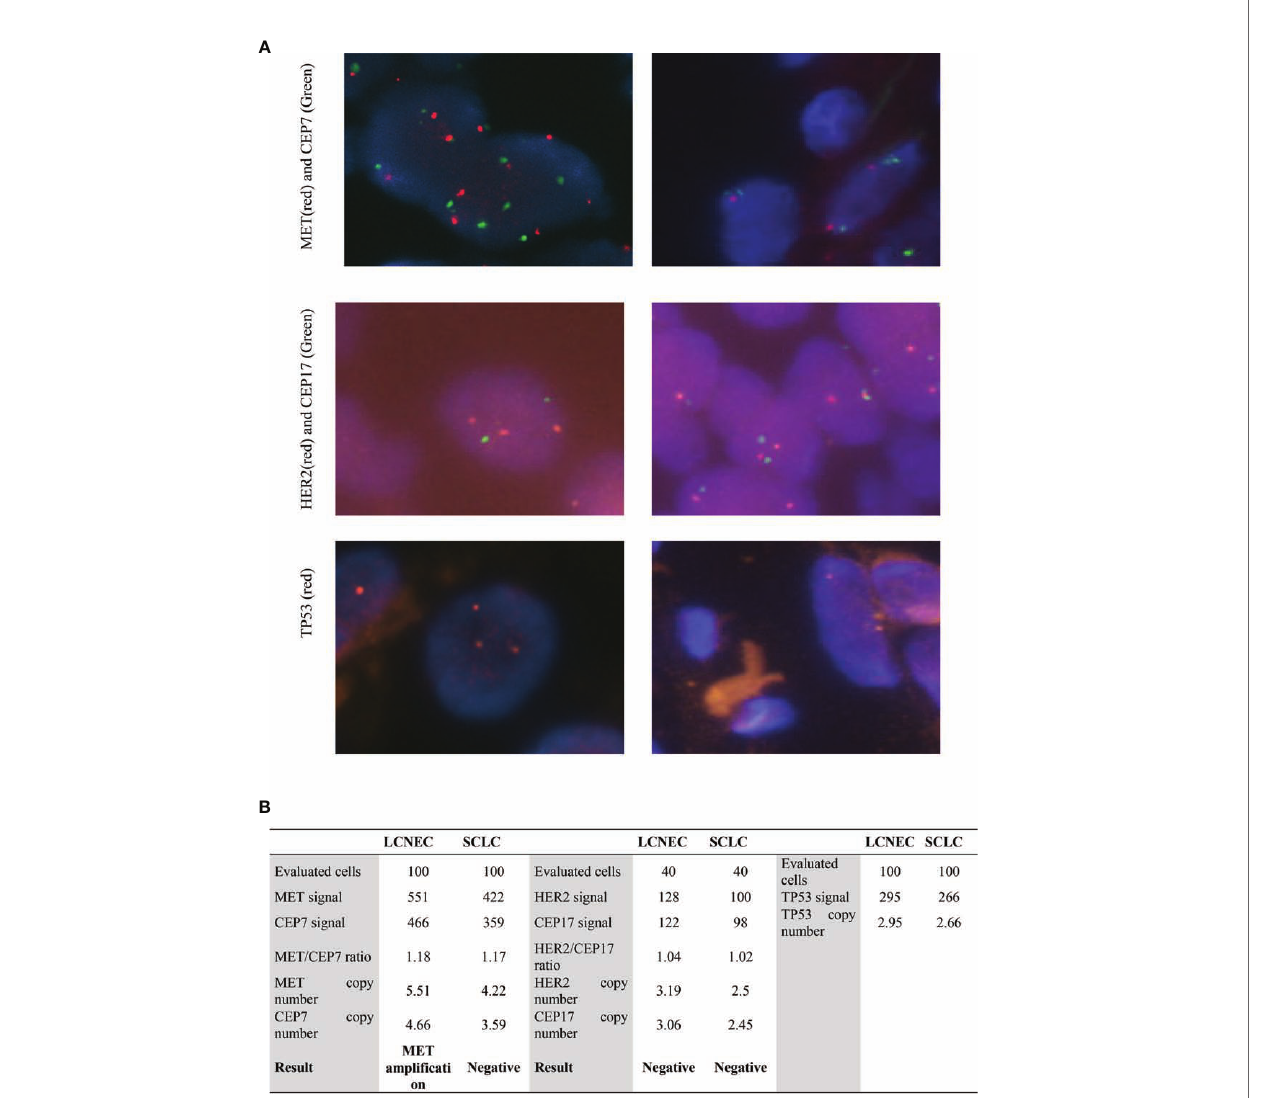
FIGURE 3 | Results of MET, HER2, and TP53 FISH in large- and small-cell components. (A) FISH images of MET, HER2, and TP53 FISH in LCNEC (left) and SCLC components (right). The magni fi cation was 1,000×. (B) Quanti fi cation of MET, HER2, and TP53 copy number in FISH. LCNEC, large-cell neuroendocrine lung carcinoma; SCLC, small-cell lung